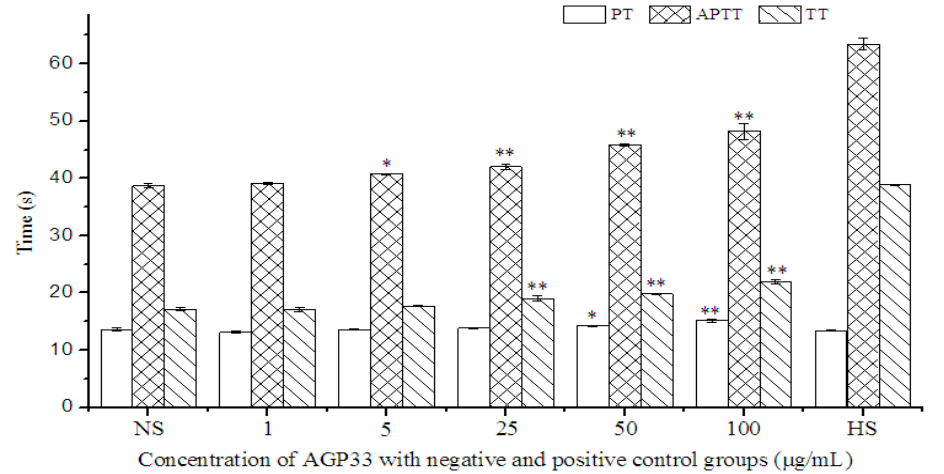
Figure 6. AGP33 prolonged APTT, PT and TT compared to normal saline (NS) group as a dose-dependent manner. The “*” means different to NS group ( p < 0.05) and “**” means